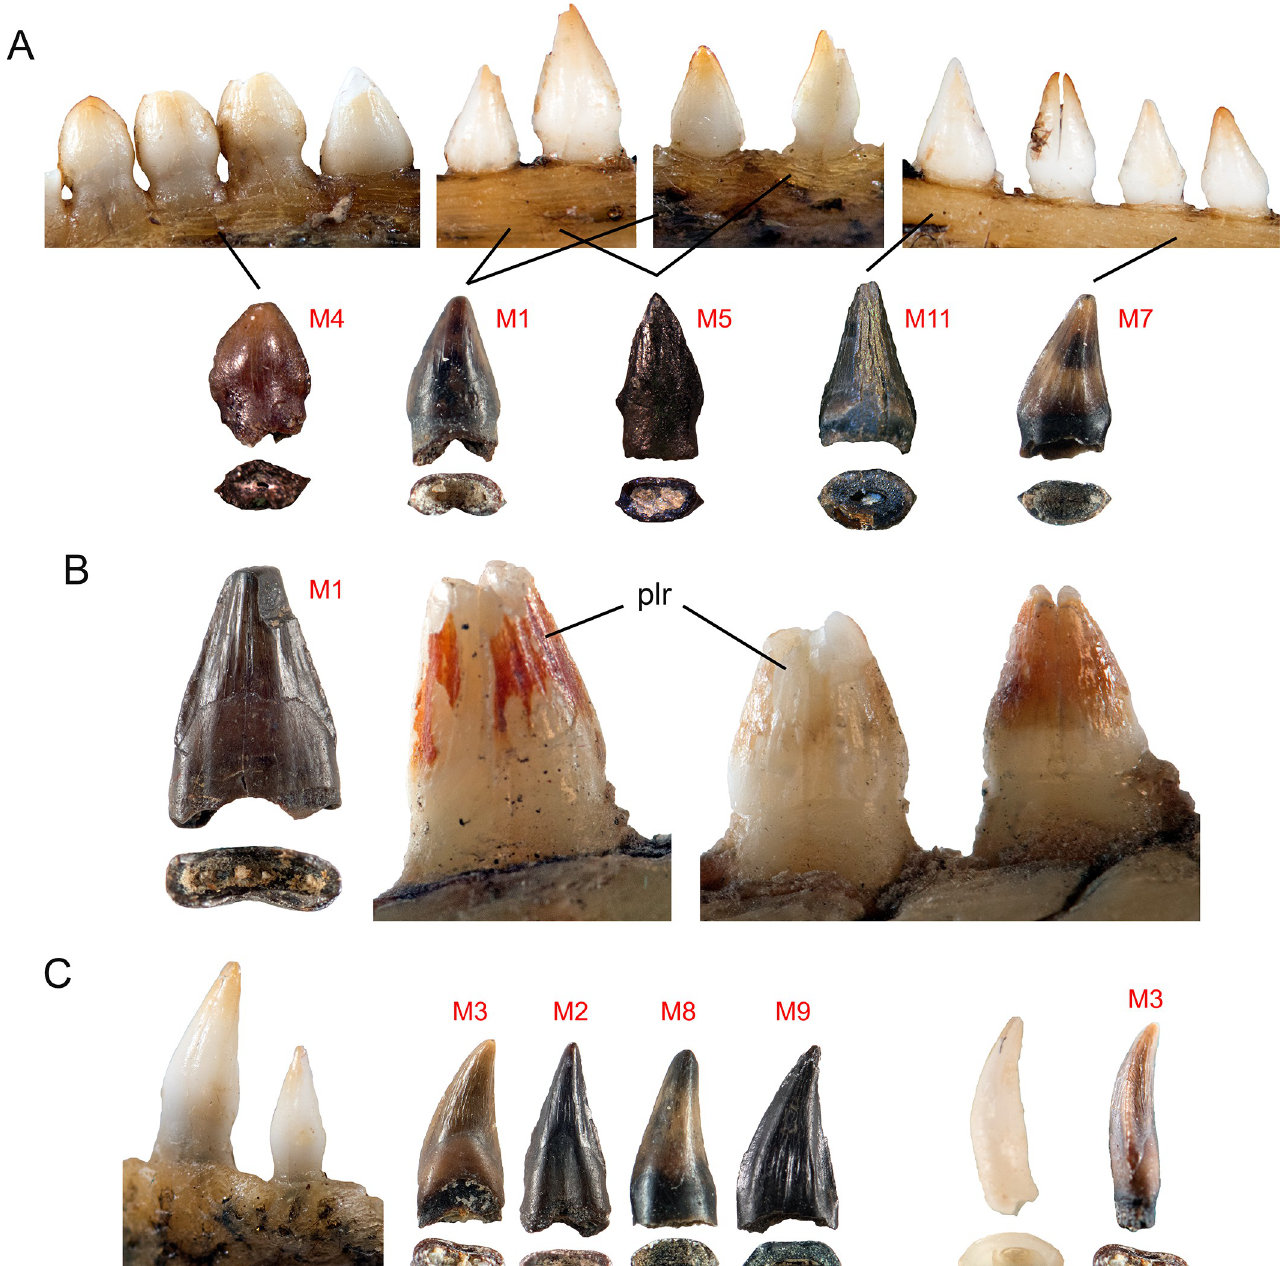
Fig 3. Comparison of putative fossil avian teeth with dentition of extant Alligator and Caiman . A , Left to right: posterior and mid-region maxillary teeth of juvenile Alligator , compared with Morphotypes 4, 1, 5, 11, 7; B , Morphotype 1 compared with Caiman teeth; C , Left, juvenile Alligator premaxillary caniniform teeth; Right, Morphotypes 3, 2, 8, 9, and comparison of Alligator caniniform tooth in mesial aspect with Morphotype 3. Abbreviation: plr, primary longitudinal ridges. Images not to